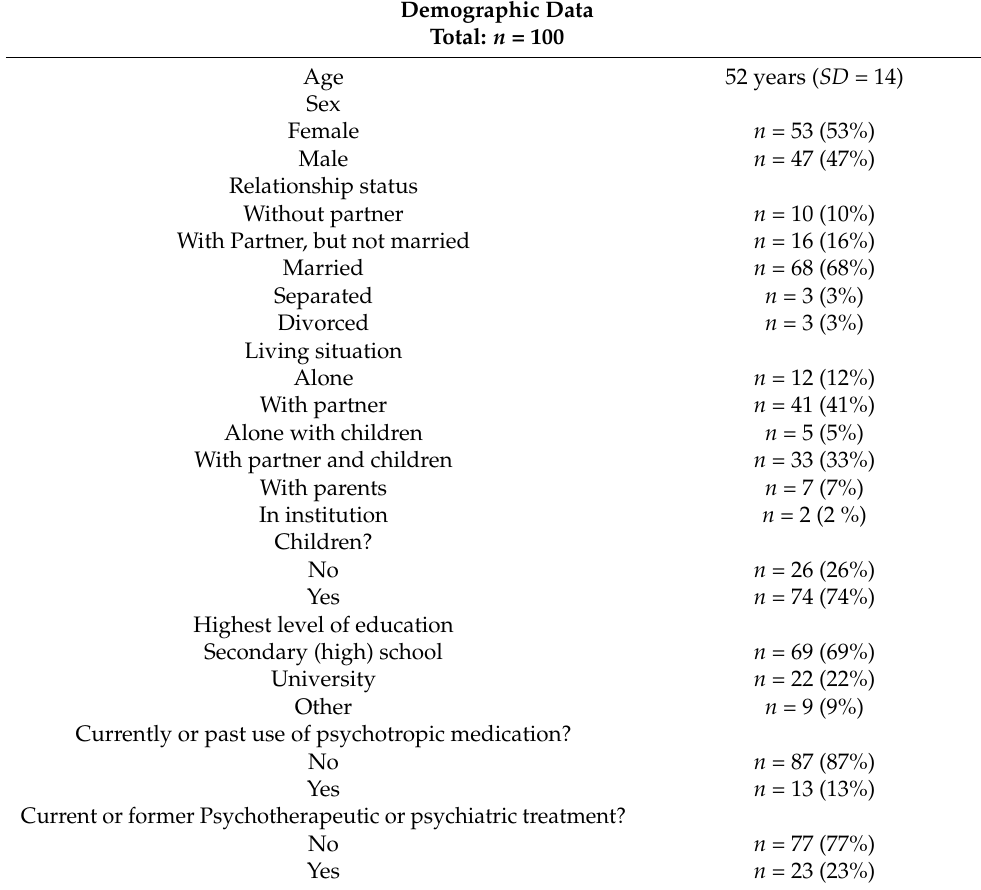
Table 1. Participants‘ demographic data.